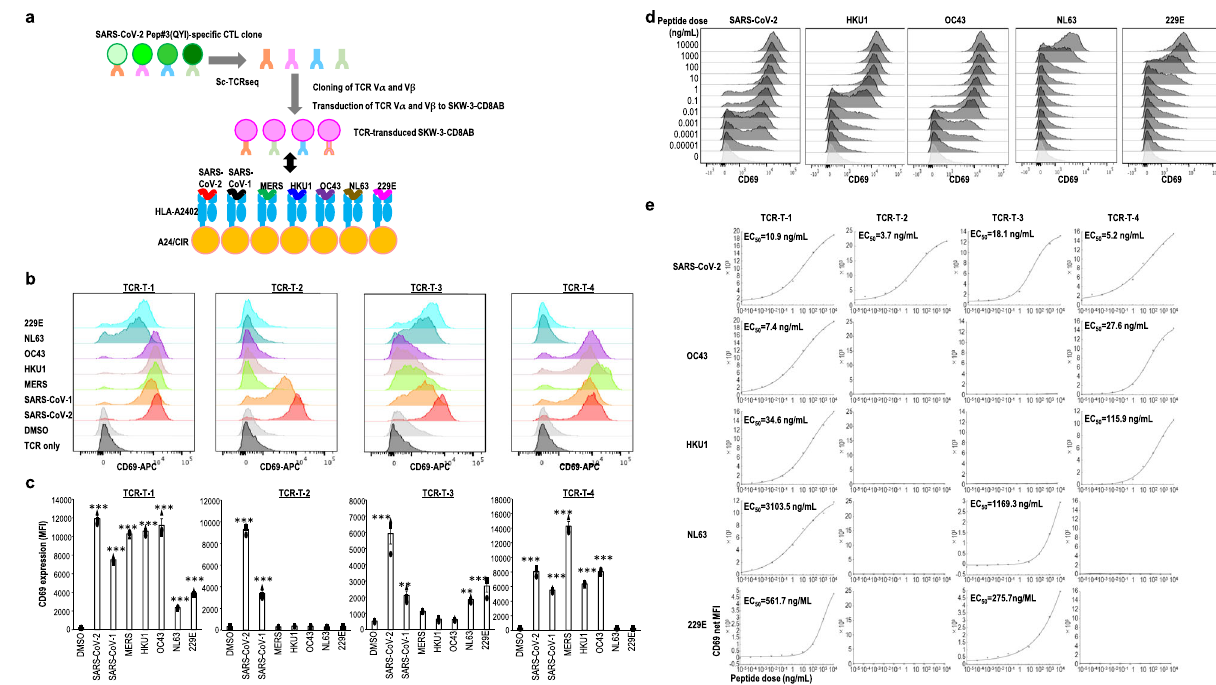
Fig. 7 Cross-reactivity of cloned TCRs across coronaviruses. a Cross-reactivity of cloned TCRs. To obtain functional antigen-speci fi c TCR molecules from T cell repertoires of Pep#3(QYI)-speci fi c CD8 + T cell line, TCR- α / β chains were cloned from Pep#3(QYI)-speci fi c CD8 + T cells, followed by functional validation of the completed TCRs. The TCR-transduced SKW3-CD8AB cells were cocultured with the indicated peptide-pulsed A24/CIR for 16 h, and the of all experiments repeated three times. c Summary of CD69 expression (net MFI) of TCR-transduced SKW3-CD8AB cells in ( b ) is depicted. The white bar and other symbols represent the mean and each data, respectively. (mean ± SEM) * *p < 0.01, ***p < 0.001 (Newman – Keuls test). d , e Avidity of Pep#3(QYI)-speci fi c TCRs. Flow cytometry data show CD69 expression of TCR-T-1 for the indicated concentrations of peptides from SARS-CoV-2 and from seasonal coronaviruses ( d ). Based on data, half maximal response (EC 50 ) of TCR-transduced SKW3-CD8AB was measured in response to cognate peptide and the relevant peptide of seasonal coronaviruses. Plot data are shown as CD69 net MFI at peptide concentration ( e ). These data